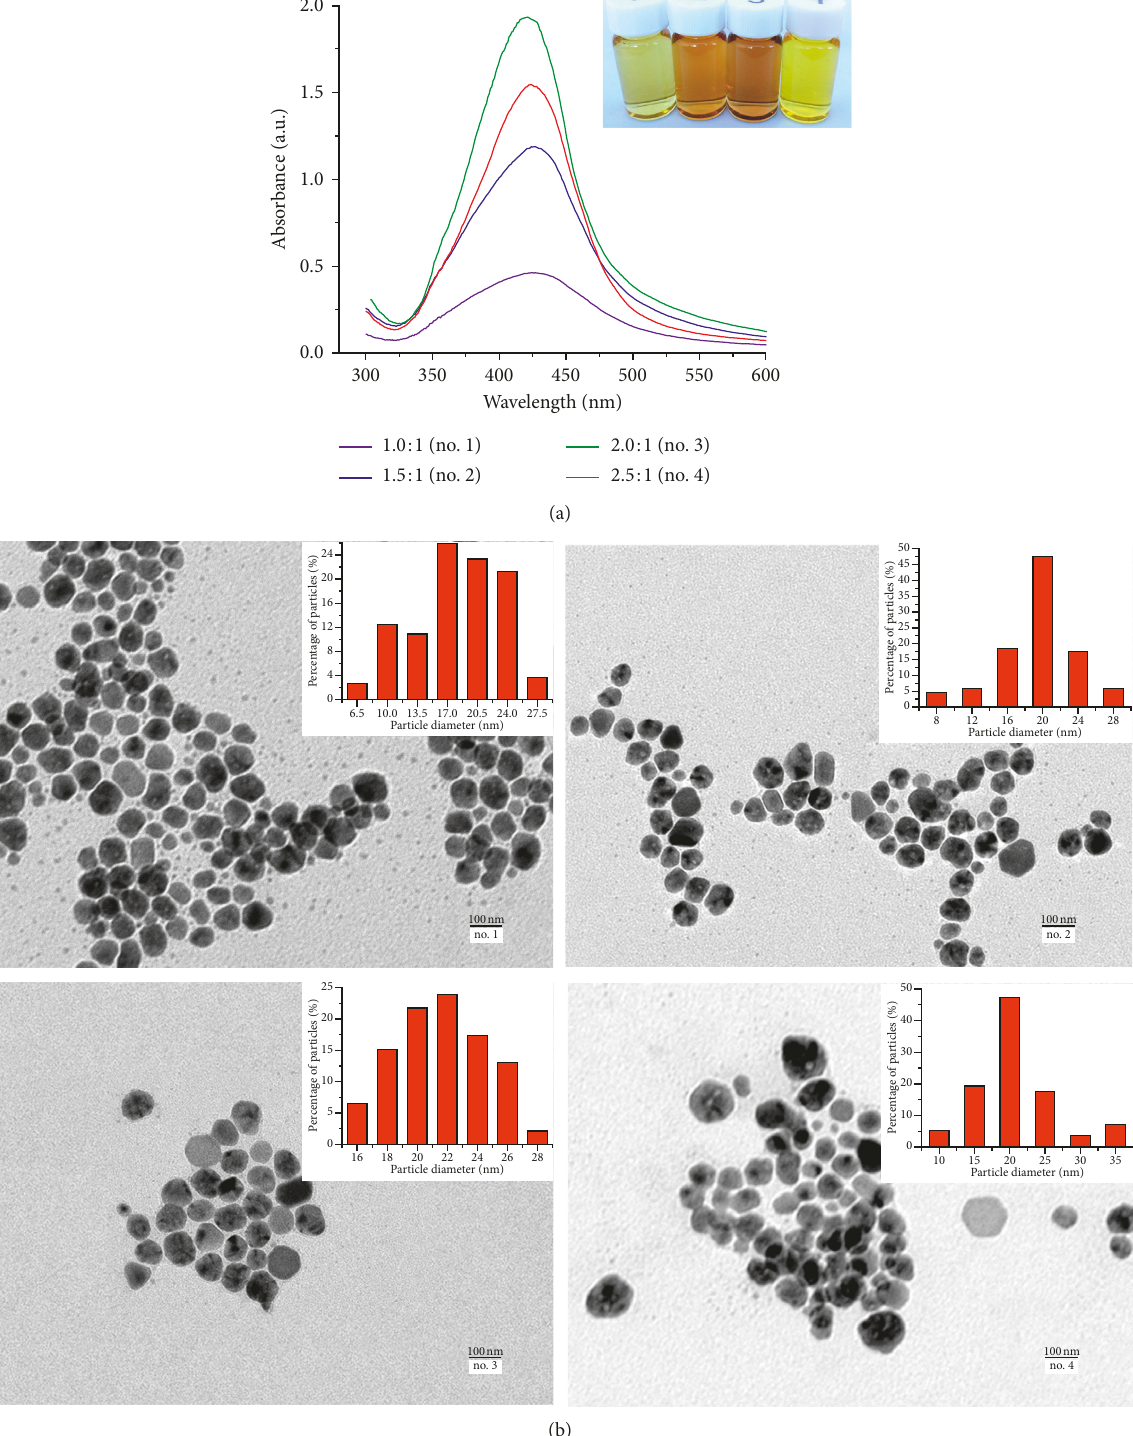
Figure 3: UV-Vis absorption spectra (a) and TEM images (b) of four groups of AgNPs synthesized under different NaOH